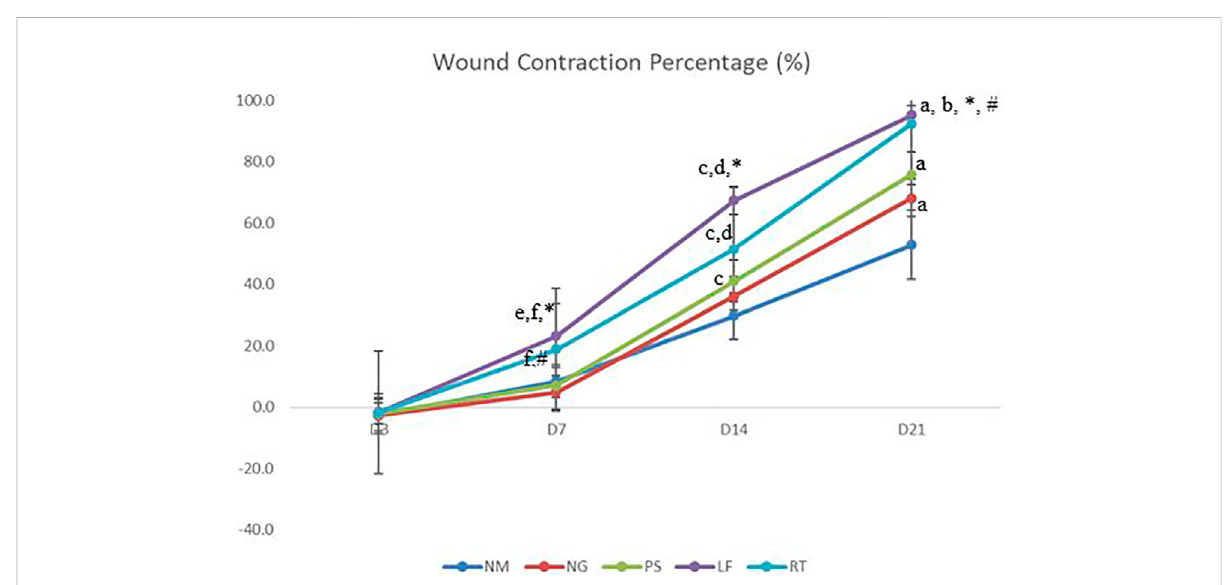
FIGURE 4 Thepercentageofwoundcontraction.NM:normalcontrolgroup,NG:negativecontrolgroup,PS:positivecontrolgroup,LF:LPValeaf-treated group, RT: LPVa root-treated group. Data were expressed as mean ± SD. Statistically signi fi cant results were indicated as (A) p ≤ 0.05 compared to NM group, (B) p ≤ 0.05 between NG group, (C) p ≤ 0.05 compared to NM group, (D) p ≤ 0.05 compared to NG group, (E) p ≤ 0.05 compared to NM group, (F) p ≤ 0.05 compared to NG group, * p ≤ 0.05 compared to LF and PS groups, # p ≤ 0.05 compared to RT and PS